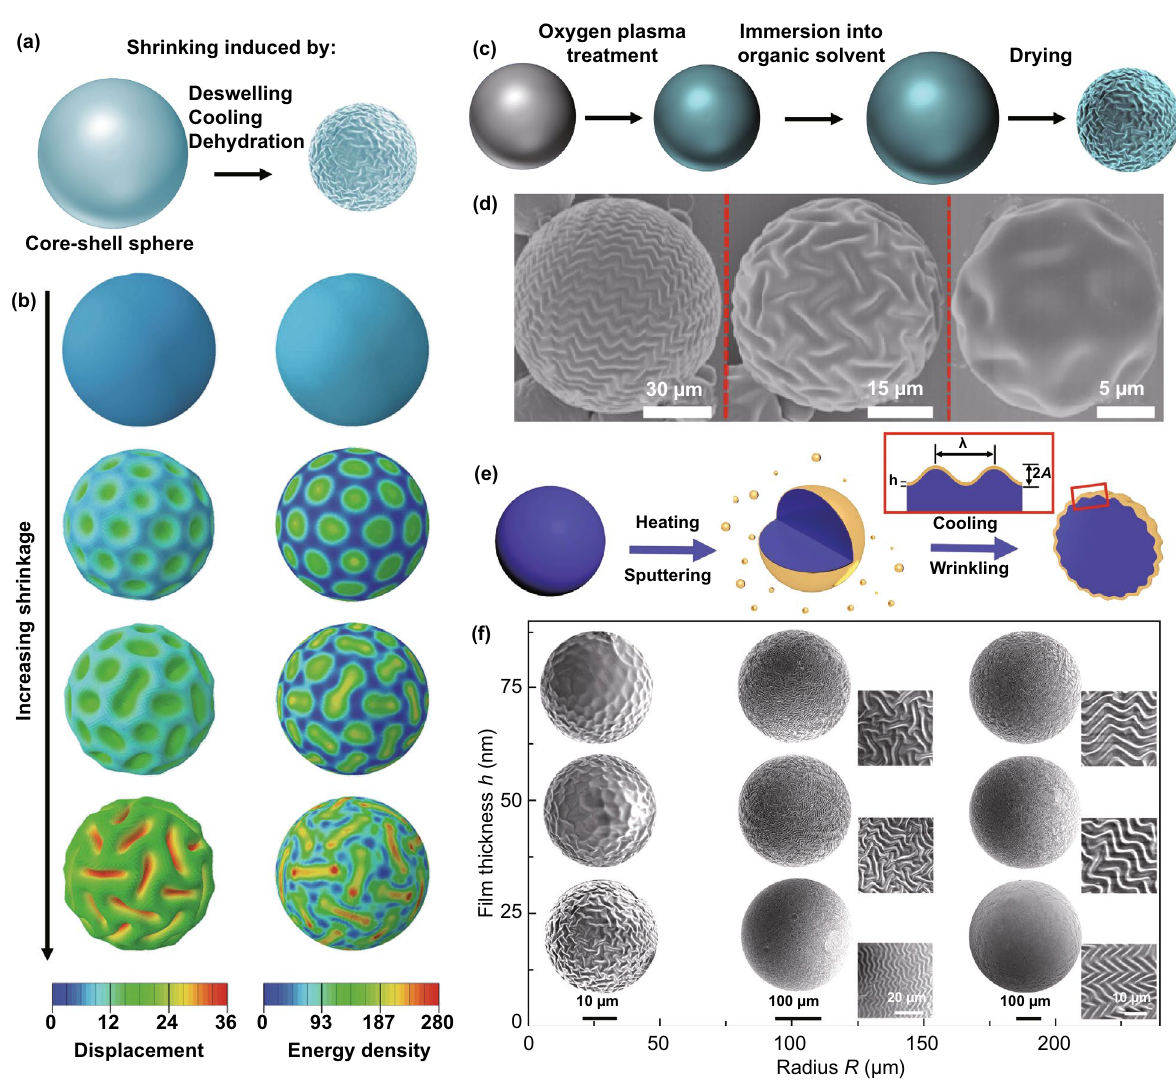
Fig. 5 Simulations and experiments of shrinkage-induced surface wrinkling of core–shell spheres. a Schematic of the shrinkage of a core–shell sphere under various stimuli. b Numerical simulation of the morphology evolution of a core–shell sphere by increasing the shrinkage [155]. Copyright 2011 American Physical Society. c , d Illustration of the procedure for the wrinkling of PDMS microspheres and SEM images of wrin- kled PDMS spheres with different radii [131]. Copyright 2015 American Chemical Society. e , f Schematic of the fabrication process for metal wrinkles on polymer microspheres and morphology evolution of wrinkling patterns with the film thickness and the microsphere radius [59]. Copyright 2019